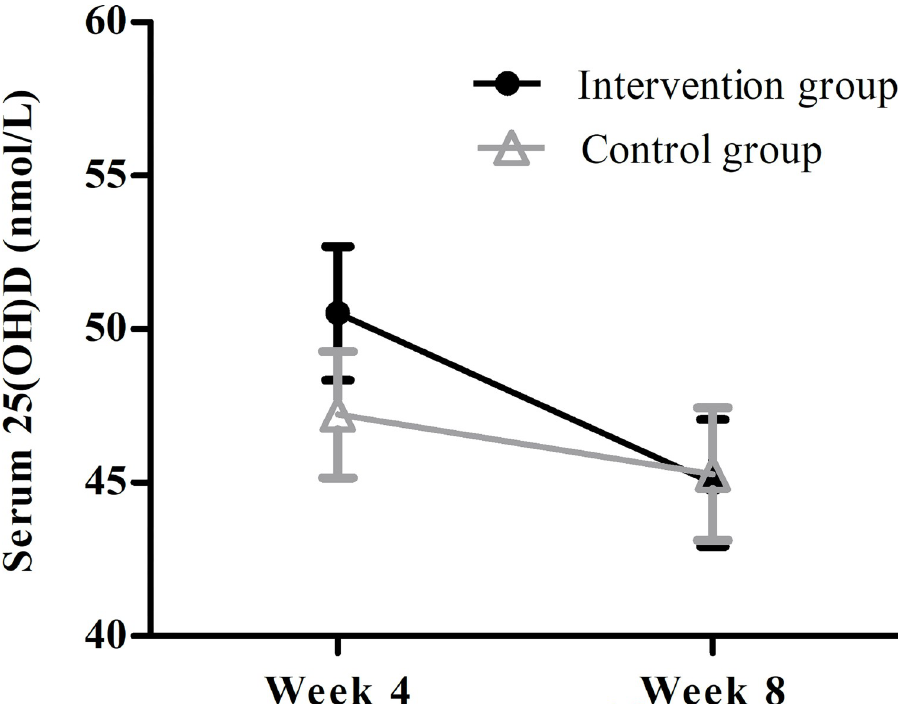
Fig 2. Average serum 25(OH)D over time (Week 4 and 8) in both groups corrected for baseline values and time spent outside. Error bars represent SE ’s. The study period was from January (Baseline) to March (Week 8).